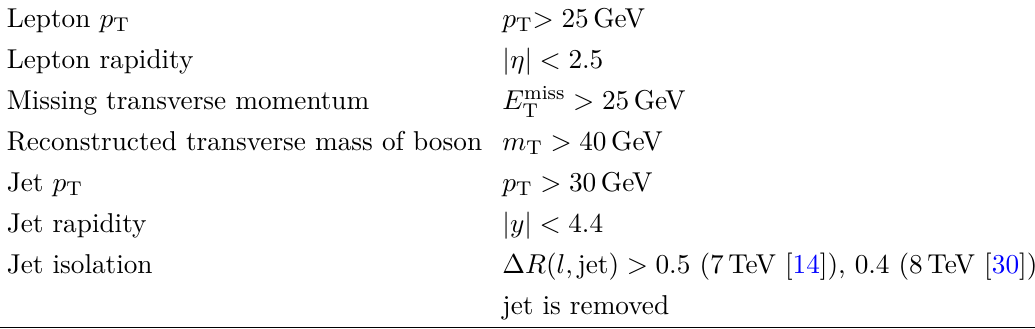
Table 2. The selection cuts used for the comparisons to